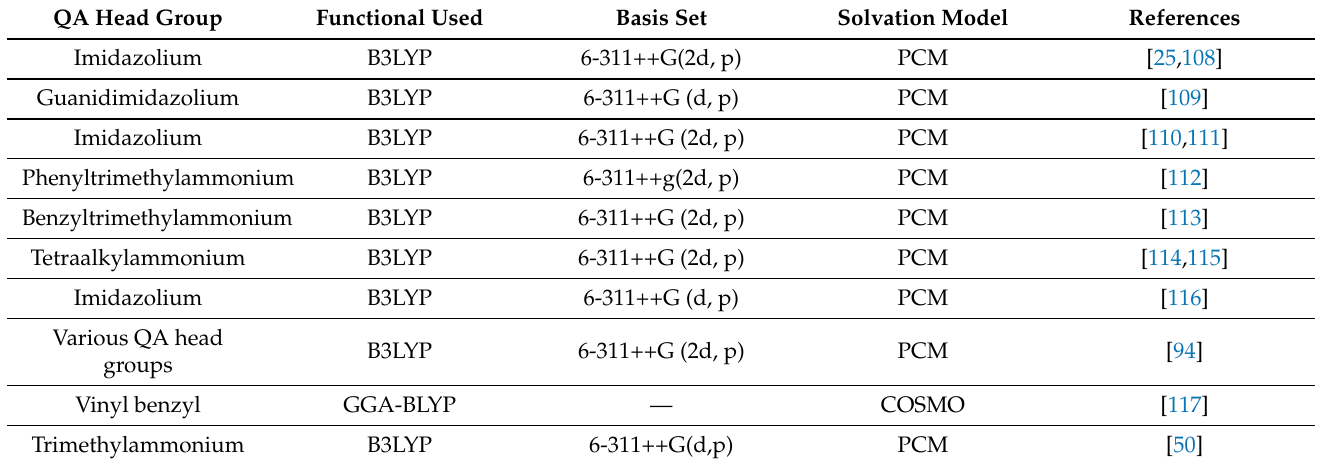
Table 1. Recent DFT-based computational studies on